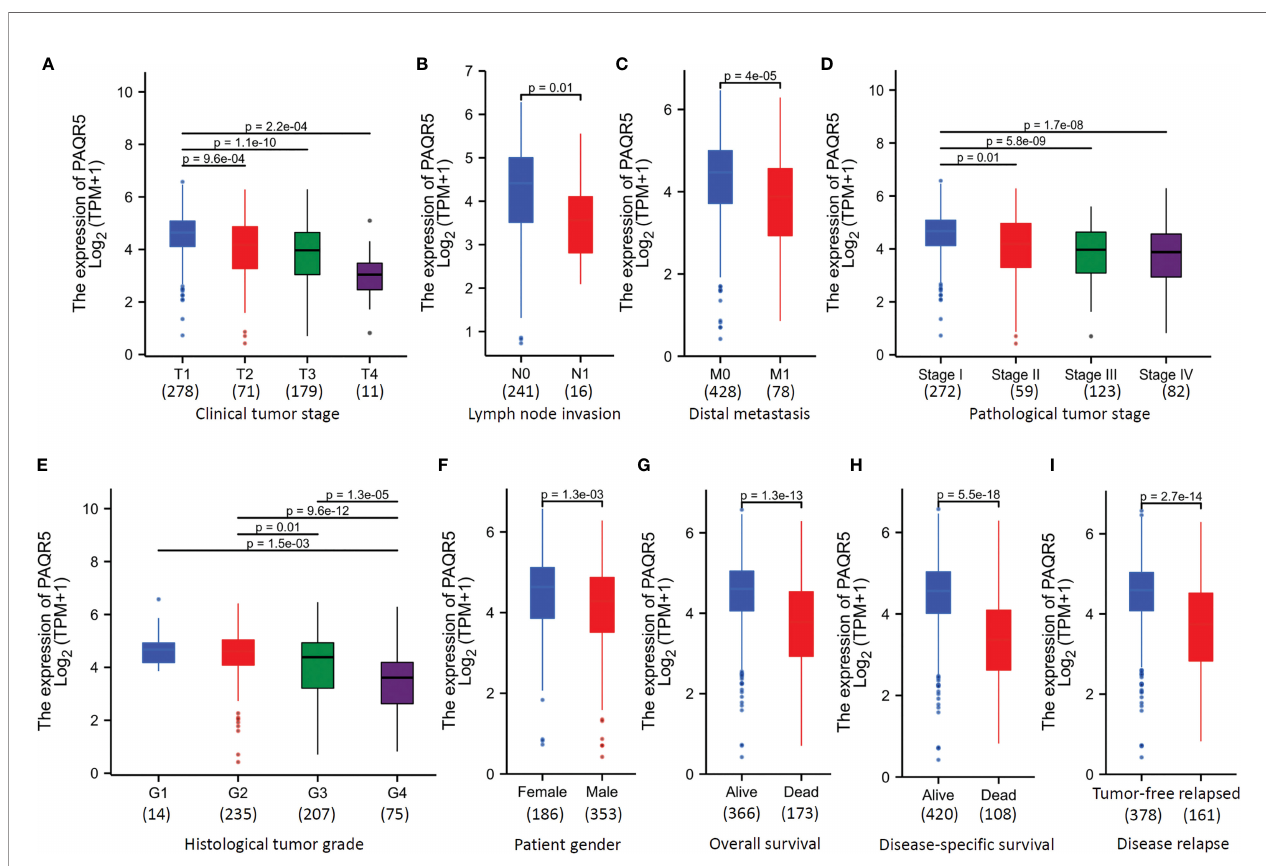
FIGURE 2 | PAQR5 expression is inversely associated with disease progression in ccRCC patients. (A – I) The RNAseq dataset from the TCGA project was used to compare different clinicopathological parameters. Multiple group comparison (panel A, D, E ) was conducted using the Kruskal-Wallis test followed by Bonferroni modi fi cation and Dunn ’ s test. Two group comparison (panel B, C, F – I ) was performed using the Wilcoxon rank-sum test. Case numbers in each sub-group were listed at the bottom of each